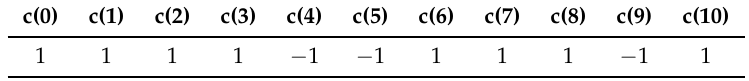
Table 1. Code cover sequence.